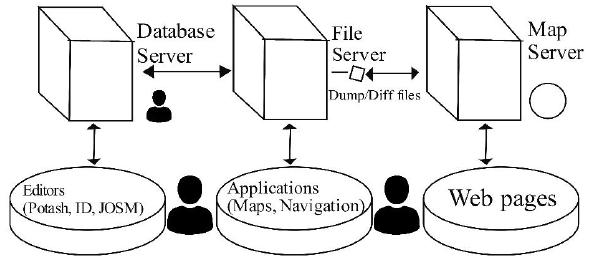
Figure 7: OSM Mapathon Infrastructure and Geostack. (Source: Neis (2014)